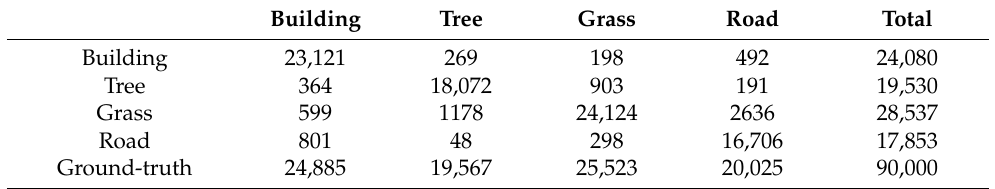
Table 8. Confusion matrix on test set 1.